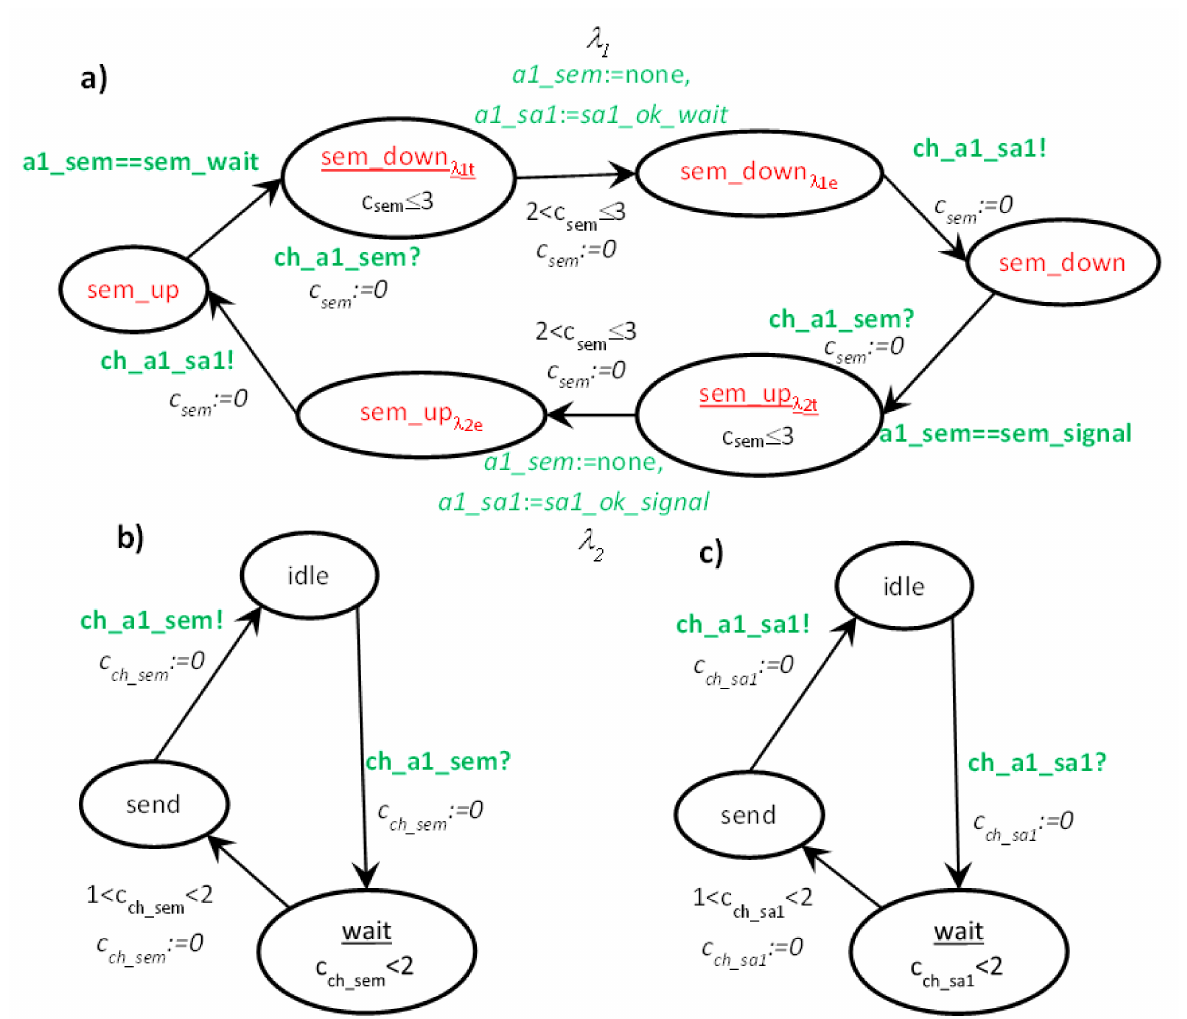
Figure 7. The UTA implementation of the two actions presented in Figure 6, and channels delay (1,2), ( a ) the implementation of the transitions in node automaton sem , ( b ) the implementation of the asynchronous channel transferring messages to the node sem , ( c ) the implementation of the asynchronous channel transferring messages to the node sa1